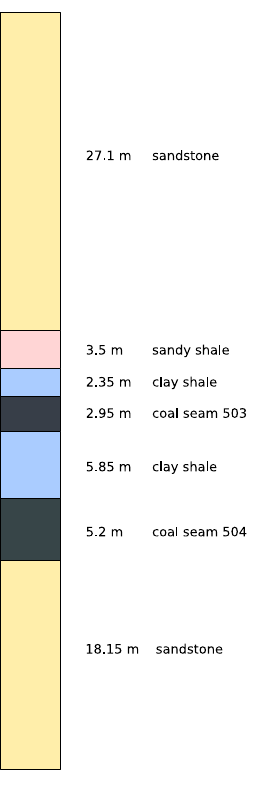
Figure 1. Geological profile in the vicinity of the coal seam 503 (based on data from Bobrek Mine).